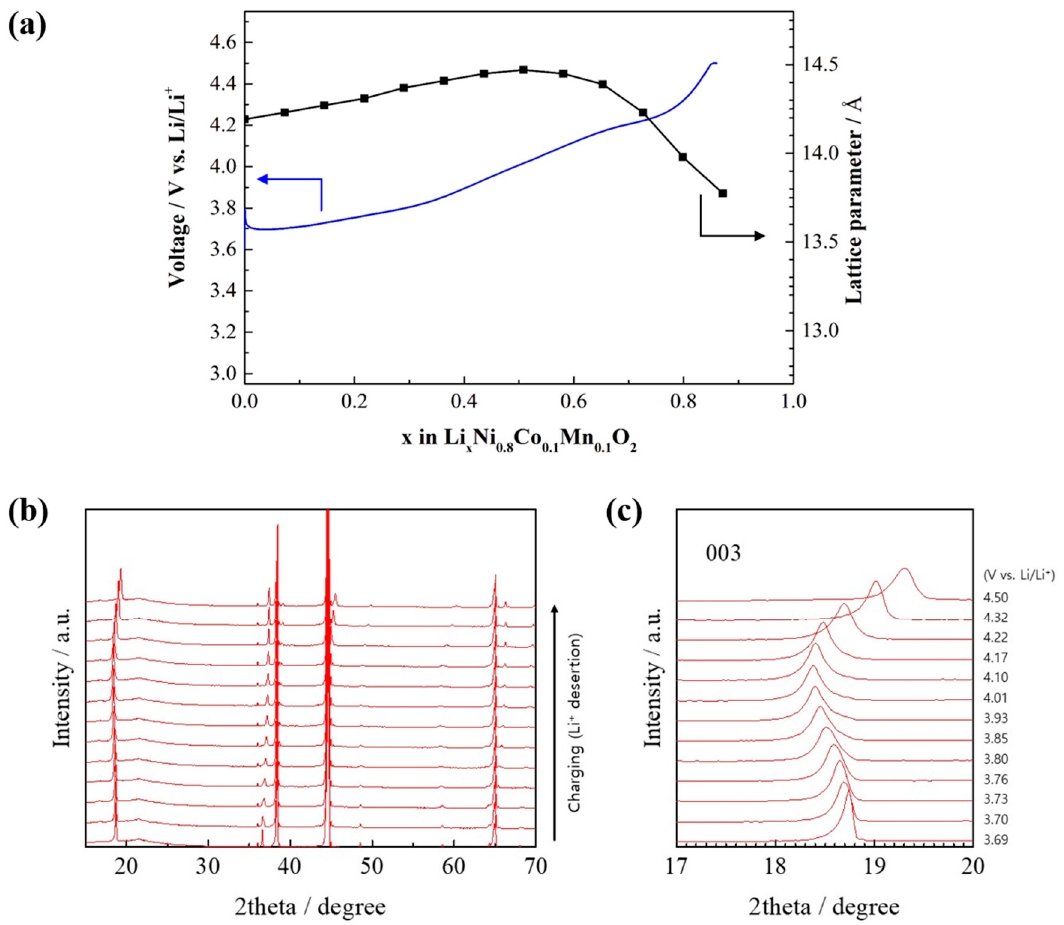
Figure 3. In situ XRD results of ( a ) the NCM811 crystal lattice variation during Li + extraction (charged state), ( b ) diffraction patterns, and ( c ) 003 reflection.